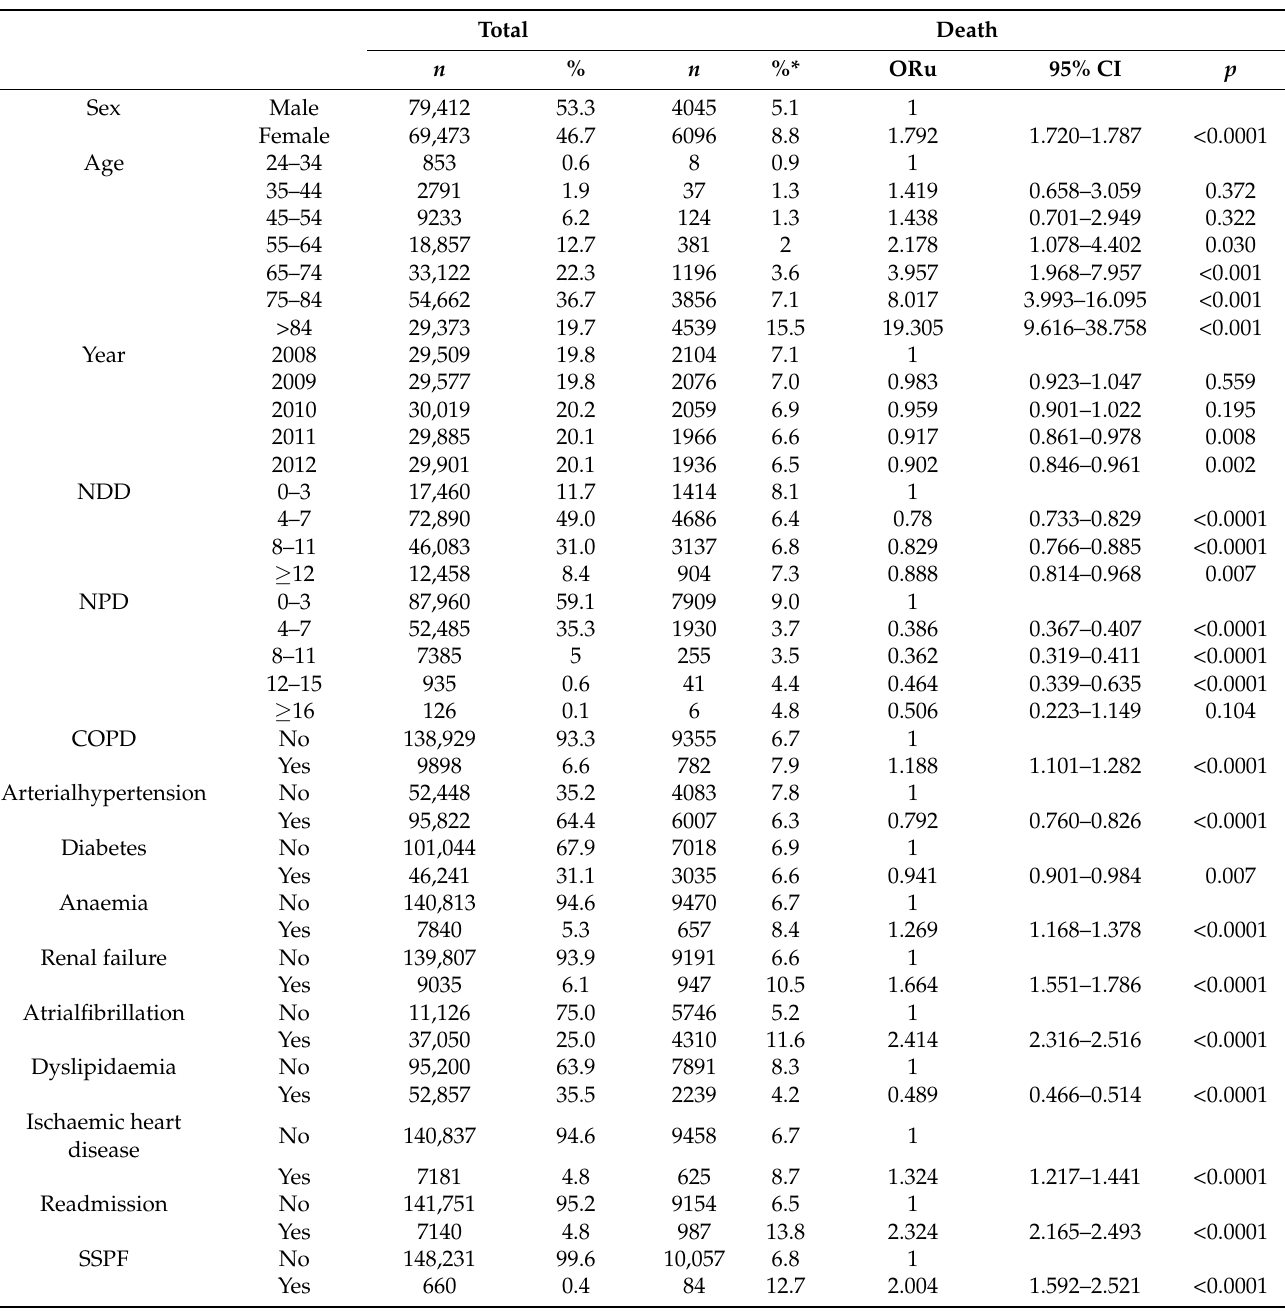
Table 2. Bivariate study. Mortality-associated factors in the training